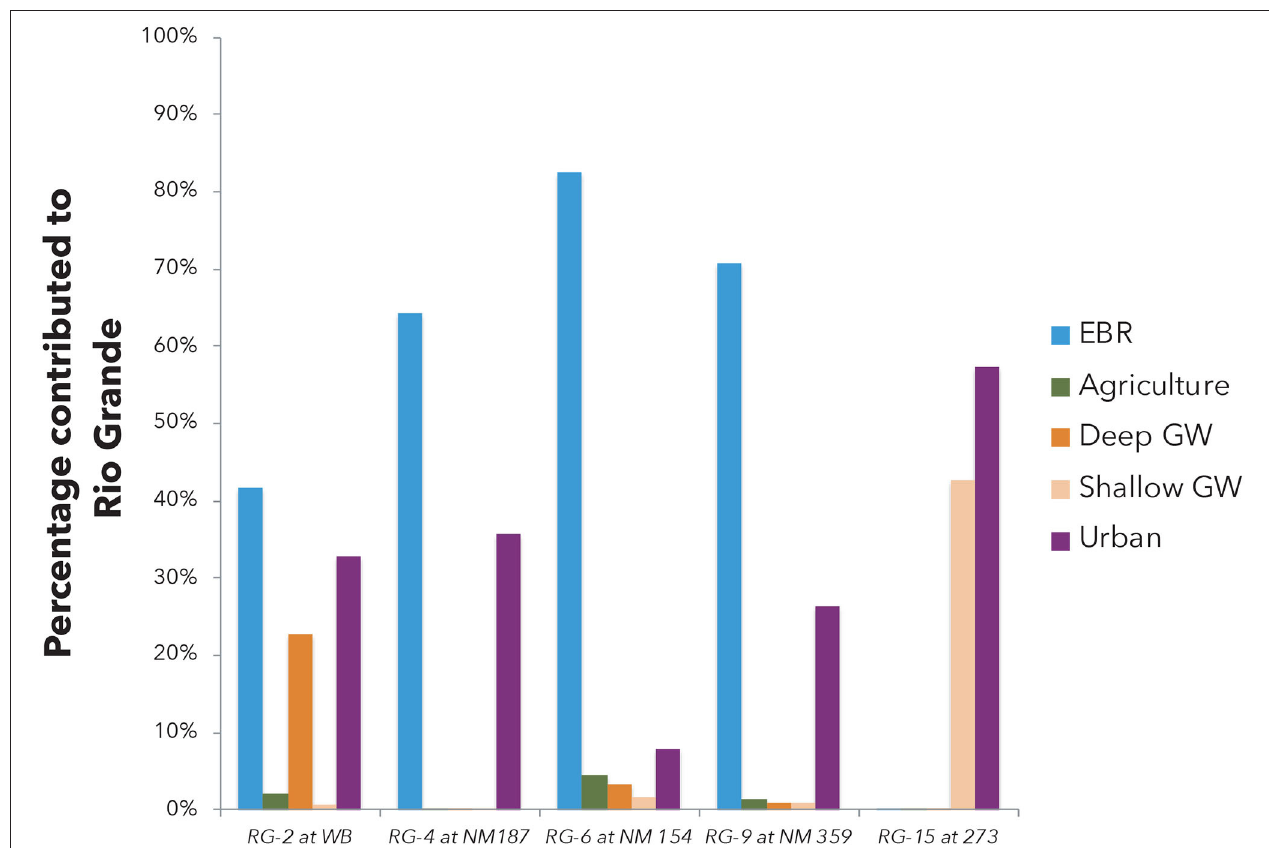
FIGURE 9 | Relative water mass contributions (%) of salinity end members to the Rio Grande river during non-irrigation seasons at the five selected locations downstream to EBR as constrained by the multi-tracer mass balance